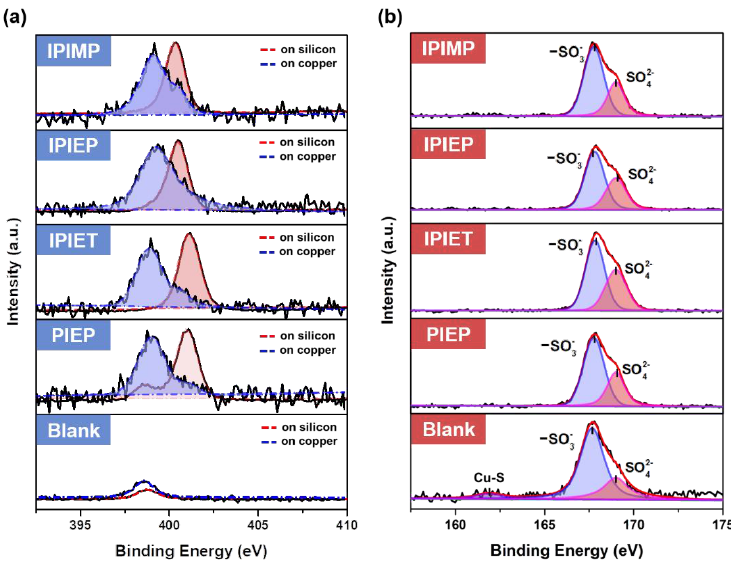
Figure 7. High-resolution XPS spectra of samples: ( a ) N1s peaks of oligomers on the silicon wafer and cathodic copper surface; ( b ) S2p peaks of oligomers adsorbed on the cathode.